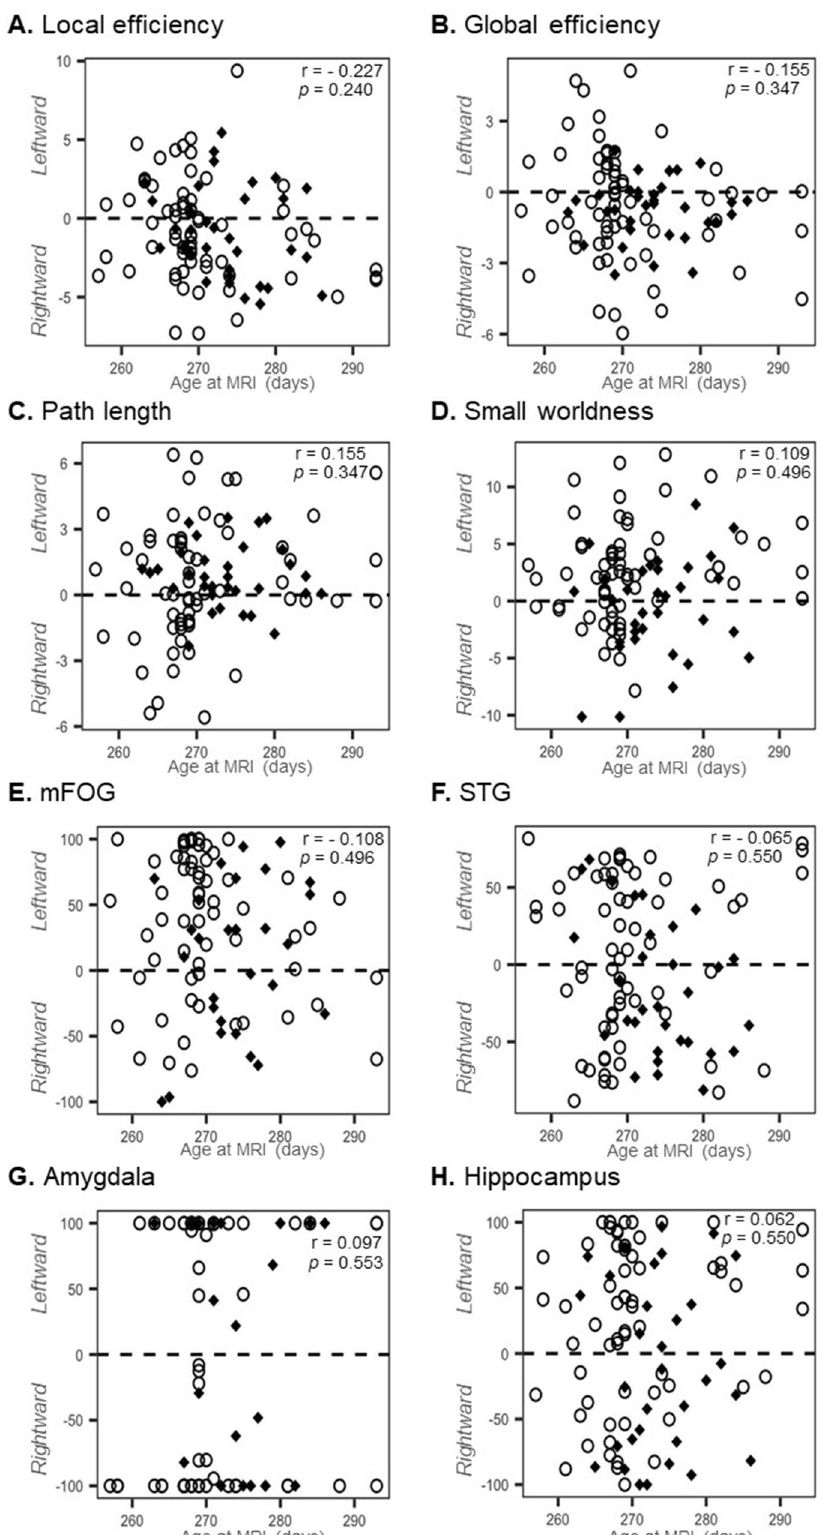
Figure 3. The features of global network asymmetries and fronto-limbic asymmetry were plotted against age at which all infants underwent the MRI scan (n = 97). P values of ≤ 0.05 were considered to indicate statistical significance. All P values were corrected for the false-discovery rate. Abbreviations: mFOG, medial fronto- orbital gyrus; STG, superior temporal